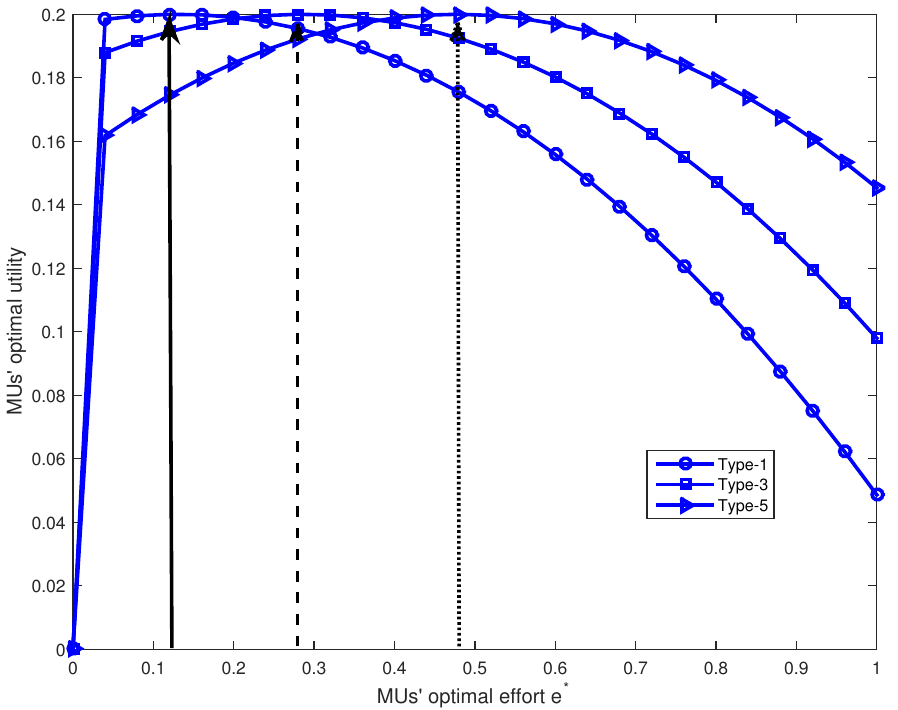
Figure 4. Mobile users’ (MUs’) optimal utility with different types of effort-incentive